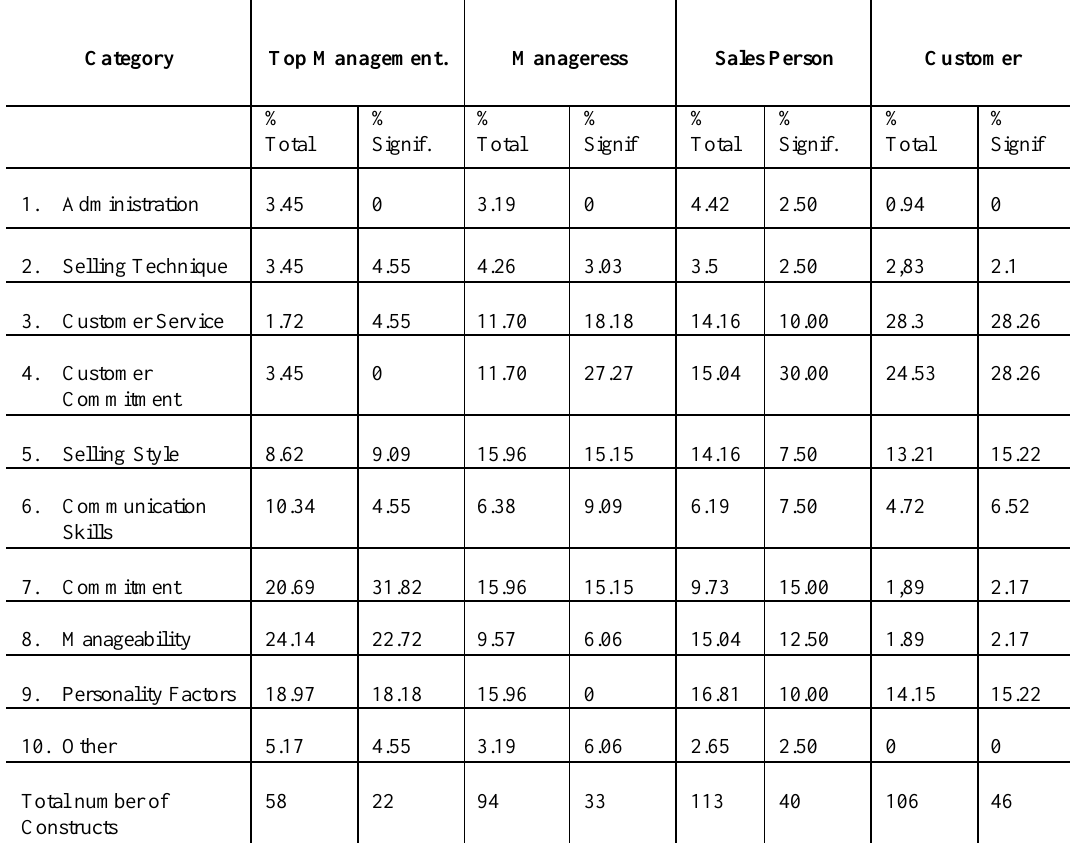
Table 3: Percentages of constructs and significant constructs by category and group